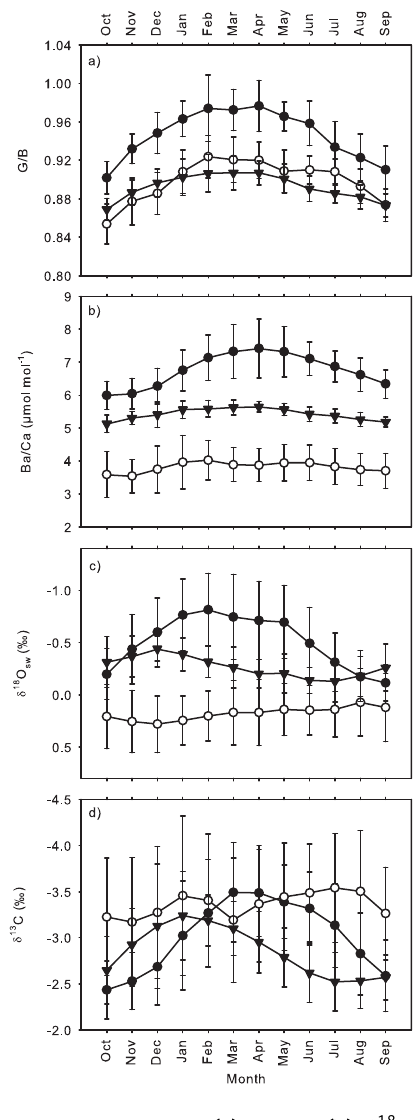
Fig. 6. Monthly averaged G/B (a) , Ba/Ca (b) , δ 18 O sw (c) and δ 13 C (d) for MAS1 (solid circles), ANDRA (open circles) and IFAHO (triangles), indicating the average seasonal cycles. Monthly averages were calculated for the 15yr period spanning January 1991 till December 2005. The standard deviations for individual months are given as error bars. The δ 18 O sw and δ 13 C is given relative to